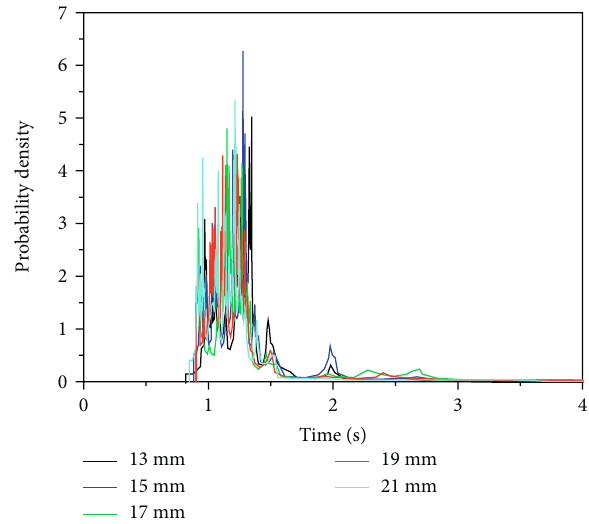
Figure 12: Influence of rotor radius on residence time